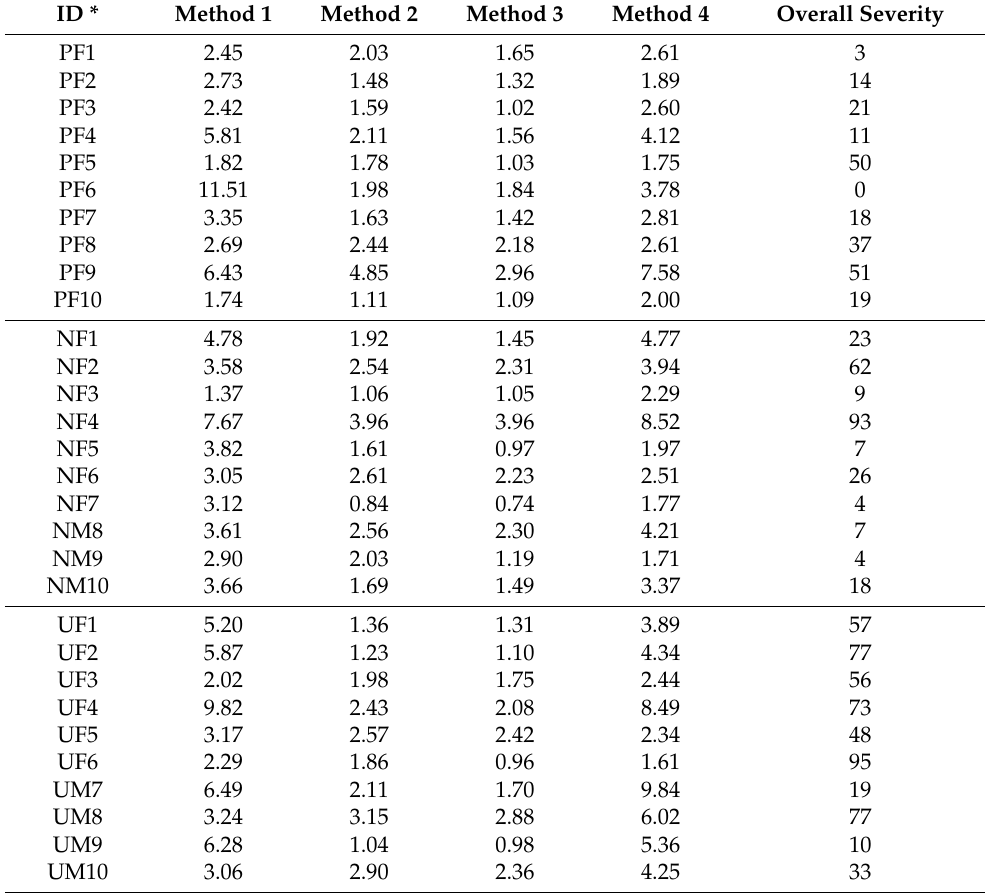
Table A1. Error of the four subglottal pressure (Ps) estimation methods for each patient in terms of root-mean-square error (units of cm H 2 O) with respect to reference Ps values measured using the indirect intraoral equilibration method. Reported also are the auditory-perceptual ratings of overall